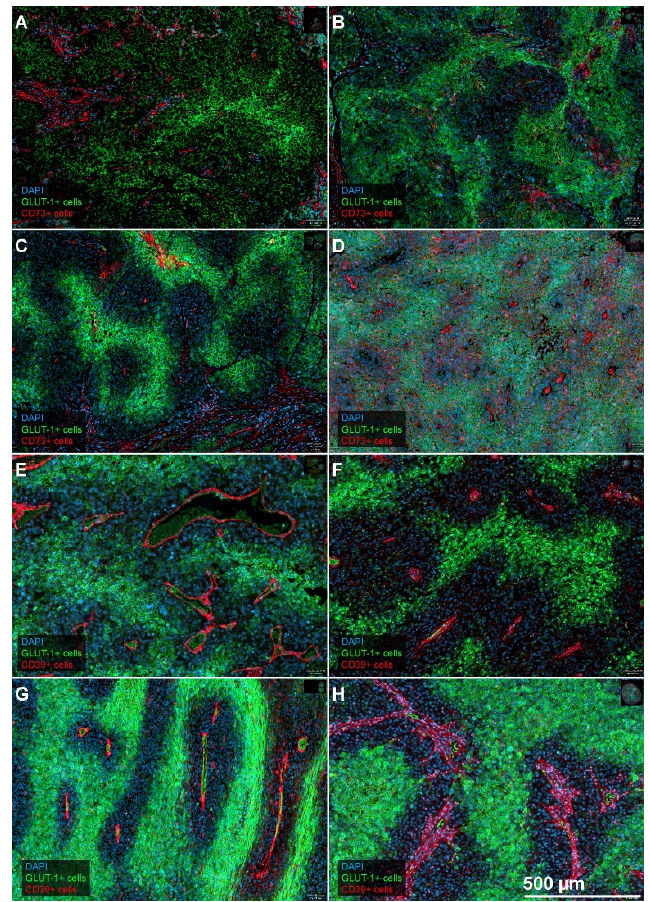
Figure 1. Representative examples for the combined expression patterns of GLUT-1 and CD73, and